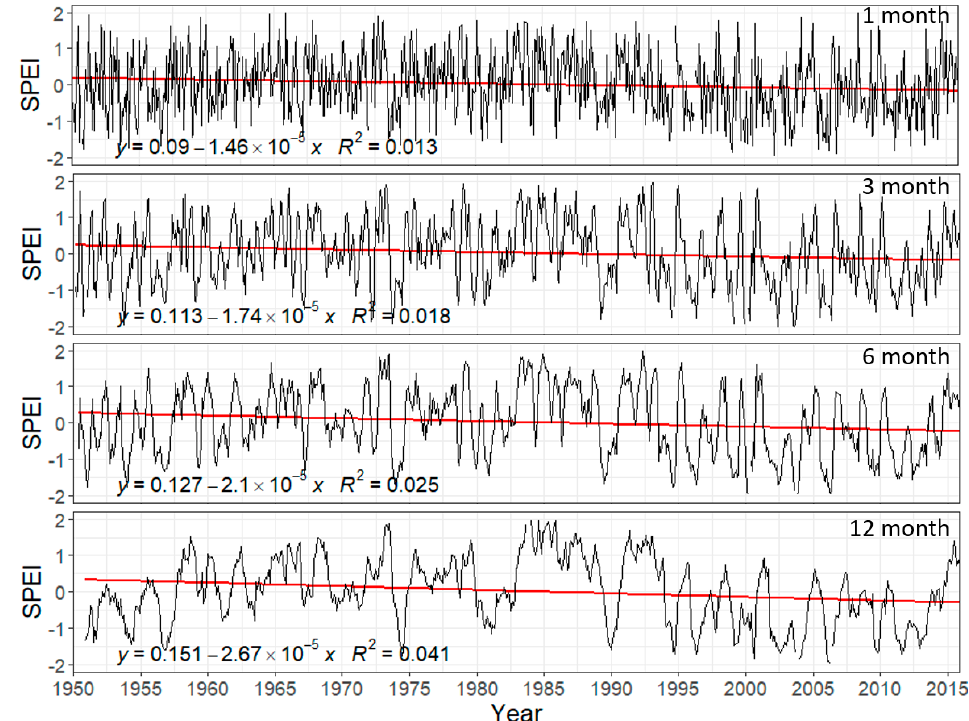
Figure A3. Time series of the spatial mean of 1-, 3-, 6-, and 12-month SPEI timescales for a period of 1950 January to 2015 December significant at p ≤ 0.05 of the Apache Highlands [31].